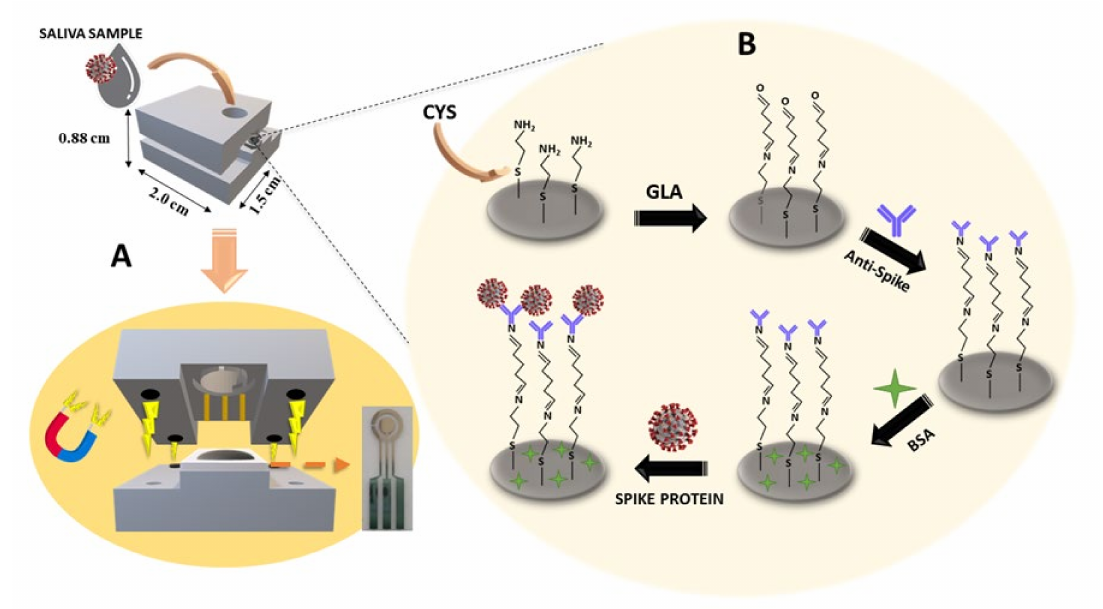
Figure 1. Representative schematic of the 3D-printed clinical analysis device in ( A ) and the steps involved in the manufacturing of the immunosensor in ( B